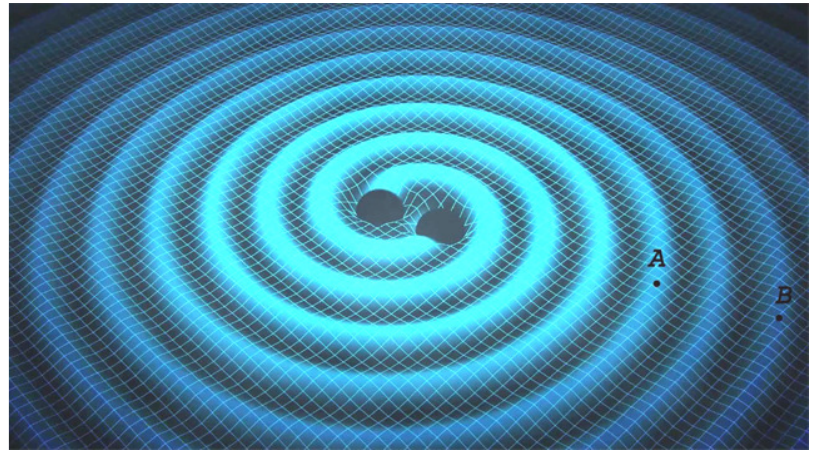
Figure 2. This naive illustration implies that the orbital velocity v of binary black holes is larger than the speed of light c , see